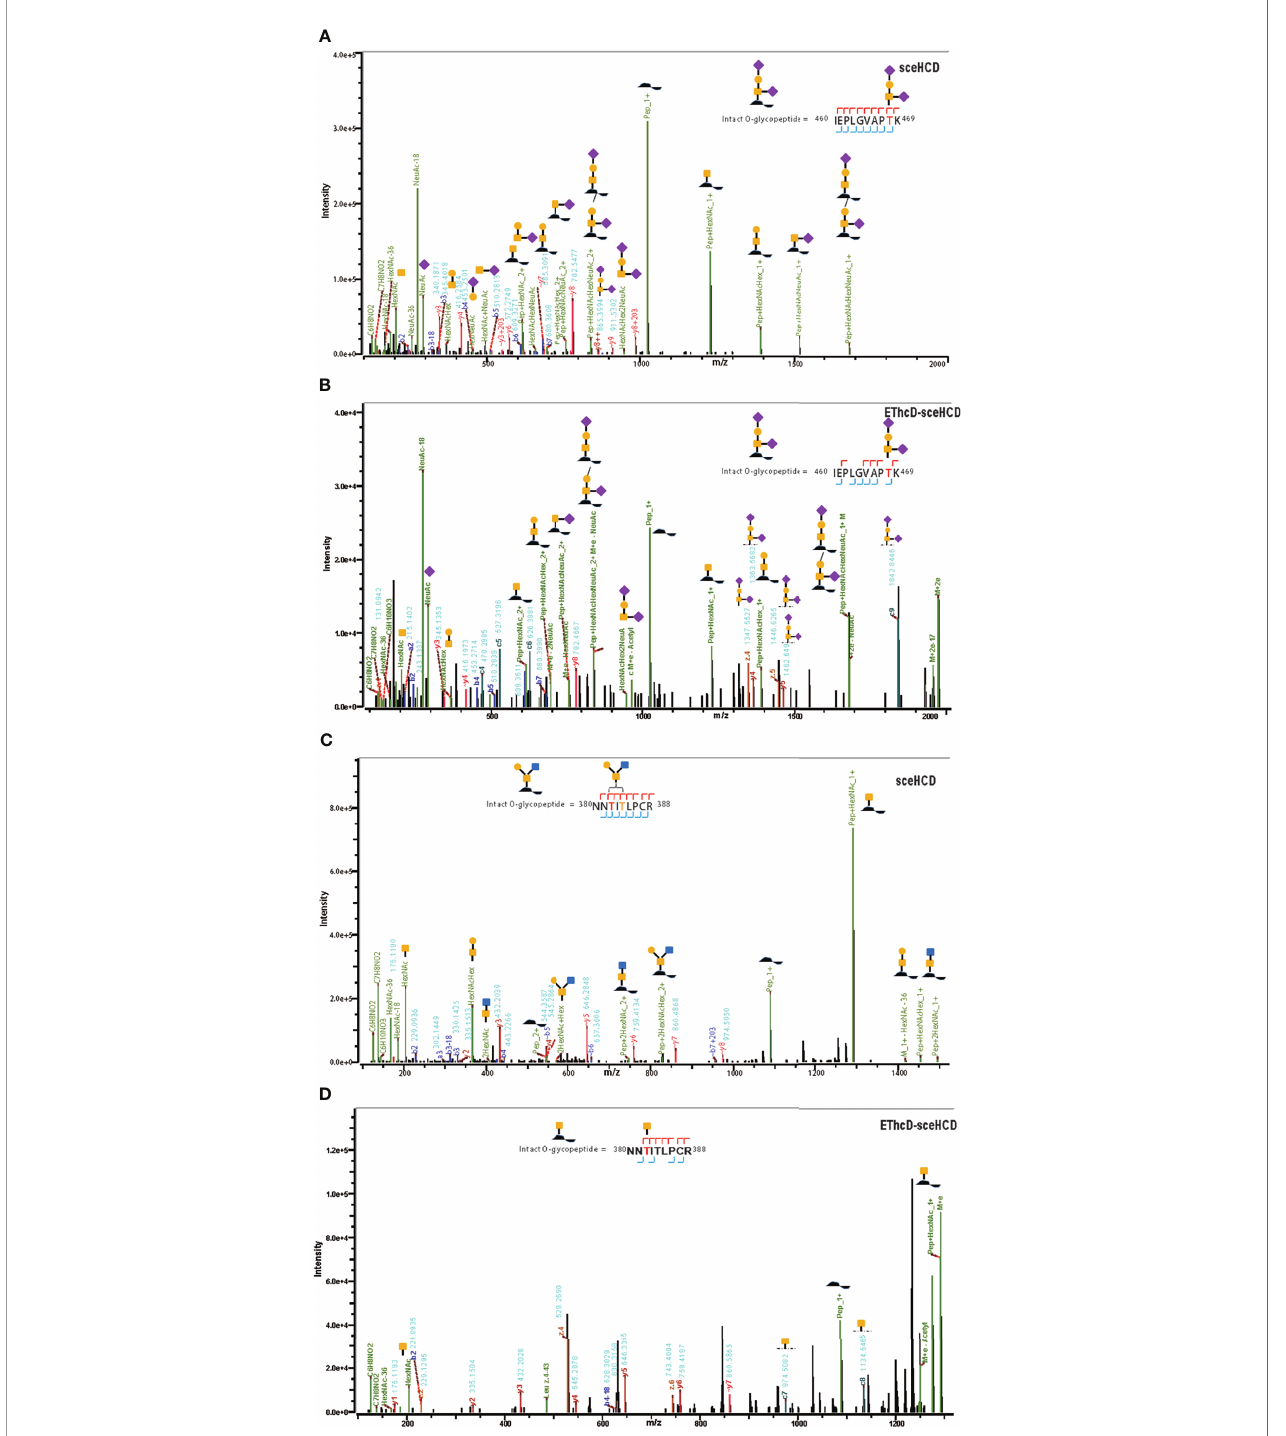
FIGURE 6 | Representative sceHCD-MS/MS (A, C) and EThcd-sceHCD-MS/MS (B, D) spectra of intact O-glycopeptides with one (T468) or two (T382 and T384) potential